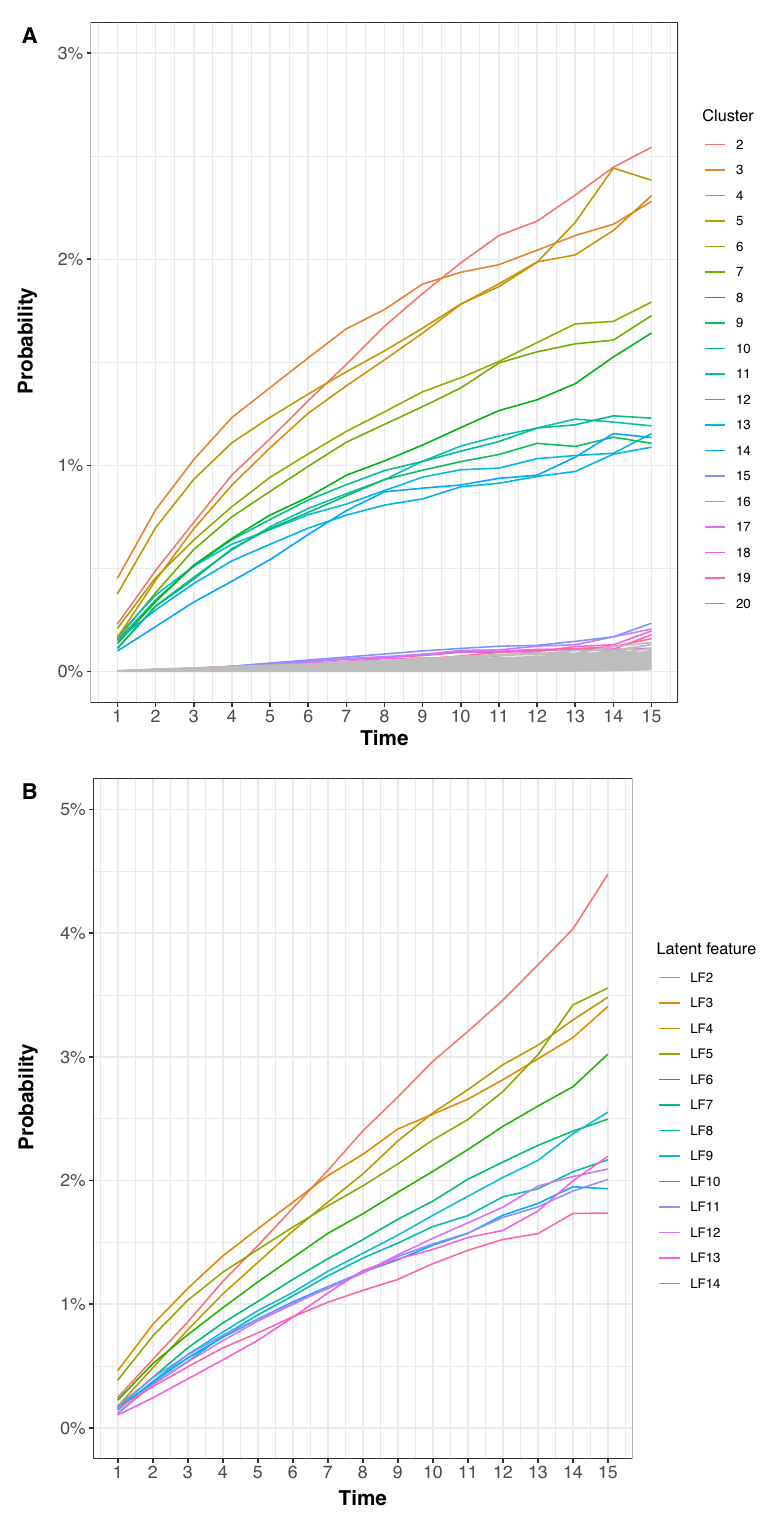
Figure 2. ( A ) Probability of belonging to each cluster over time. Note that some clusters increased at a higher rate compared to others. More information on the cluster characteristics can be found in Table 2. ( B ) Evolution of active latent features over time. Latent feature 1 is not depicted as it is always